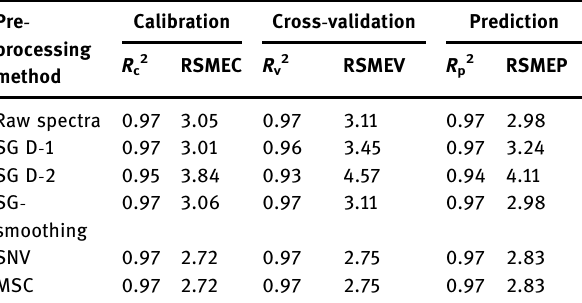
vatives, respectively; SNV – standard normal variate. MSC – multiple scatter correction; SG - smoothing – Savitzky - Golay